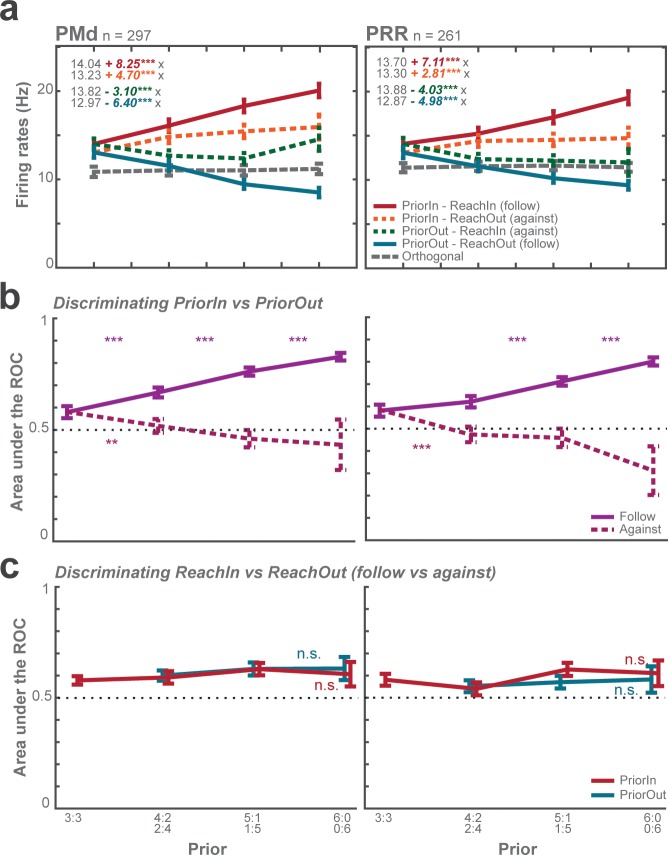
ROC analyses of choice predictive responses.(a) Average firing rates as function of prior and sorted according to Prior-in vs. Prior-out and Reach-in vs. Reach-out show that prior direction rather than later reach choice determines the neuronal response most strongly. This panel also shows that against choices did not result from unambiguous against reach-goal encoding, but rather from neural stochasticity; individual trials in which the effect of prior was not sufficiently strong, probabilistic against choices occurred. Each panel displays fitted equation using GLMM. (b) Average area under the ROC curves discriminating Prior-in and Prior-out trials (between-condition ROC). The ROC discriminability is low in zero-prior conditions and increases with prior. (c) Average area under the ROC curves discriminating follow and against trials as function of prior (within-condition ROC). The average discriminability of later choice stagnated around 0.6 across prior levels with no significant biasing effect in either area. This means, neuronal fluctuations across trials with the same level of action priors were not predictive about later reach choice. Taken together, the choice predictive and ROC analyses confirm that the animals did not alternate over trials between two premature unambiguous reach plans. Error bars depict standard errors. Pairwise comparisons b-c: *p < αcorr at 5%, **p < αcorr at 1%, ***p < αcorr at 0.1%; Bonferroni-corrected t-test.